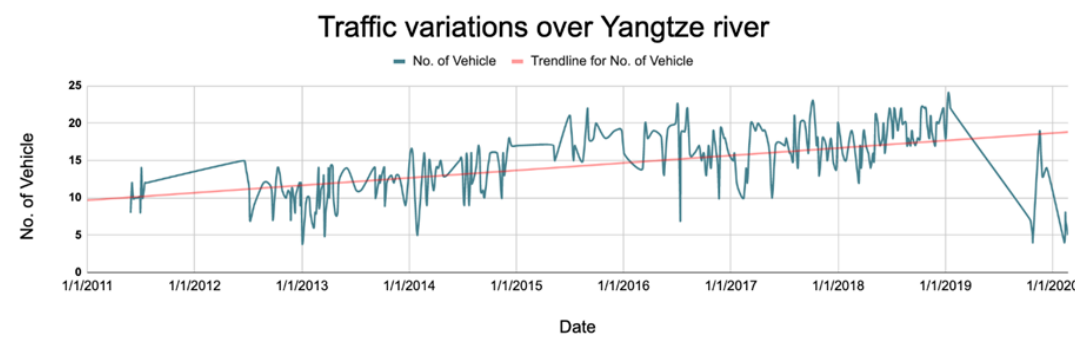
Figure 11. Overall vehicle traffic on the seven bridges crossing the Yangtze river within the city of Wuhan, estimated based on the COSMO-SkyMed data analysis for the period 2011–2020.